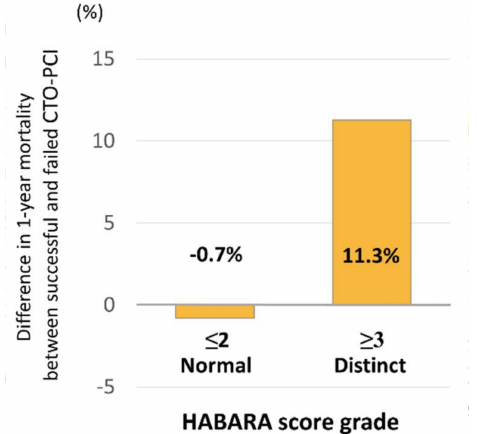
Figure 4. Di ff erence in one-year mortality between patients with successful CTO-PCI and those undergoing failed procedure, stratified by the HABARA score grade. Abbreviations: CTO, chronic total occlusion; HABARA, how aggressively the successful result of CTO-PCI should be achieved by the operator; PCI, percutaneous coronary